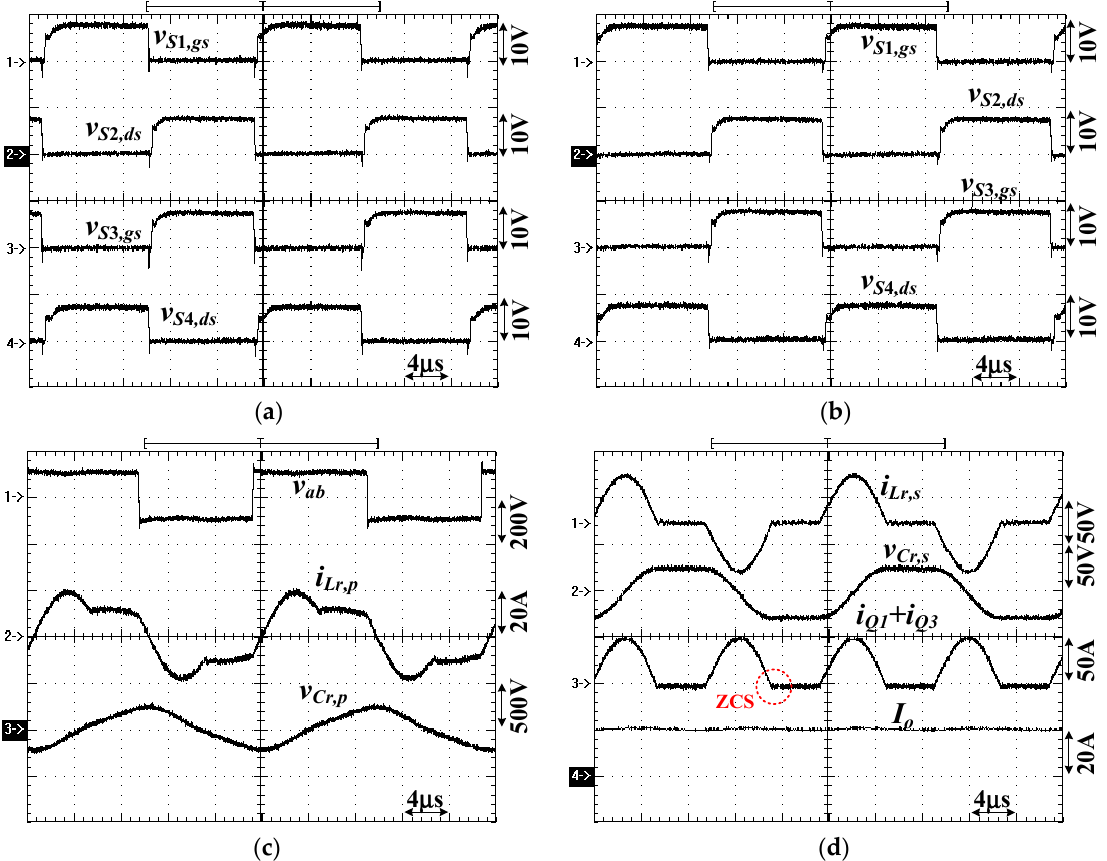
Figure 11. Measured waveforms of the proposed converter operated at forward power flow and V in = 100 V: ( a ) S 1 – S 4 signals at 20% load power, ( b ) S 1 – S 4 signals at 100% load power, ( c ) v ab , i Lr,p and v Cr,p at full rated power, ( d ) i Lr,s , v Cr,s , i Q 1 + i Q 3 and I o at full rated power.